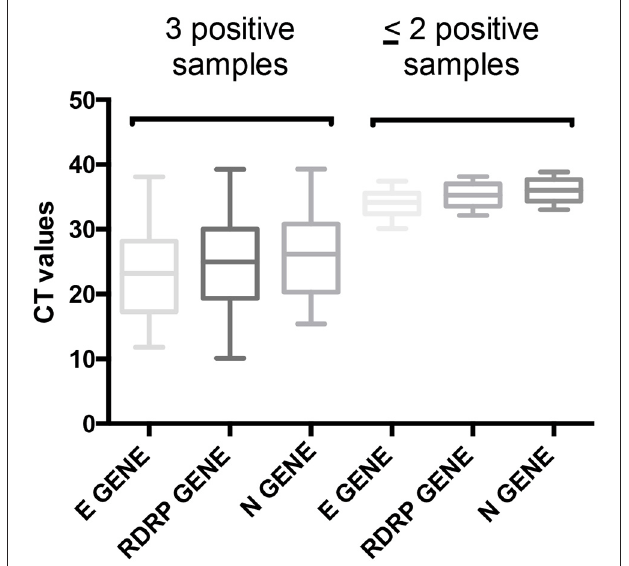
FIGURE 3 | Comparison of Ct values depending on the number of positive samples. Ct values of samples that are positive for the three sampling methods (three positive samples) and for at least two sampling methods ( ≤ 2 positive samples). NPS, nasopharyngeal swab; NTMS, nasal midturbinate swab; SALIVA,